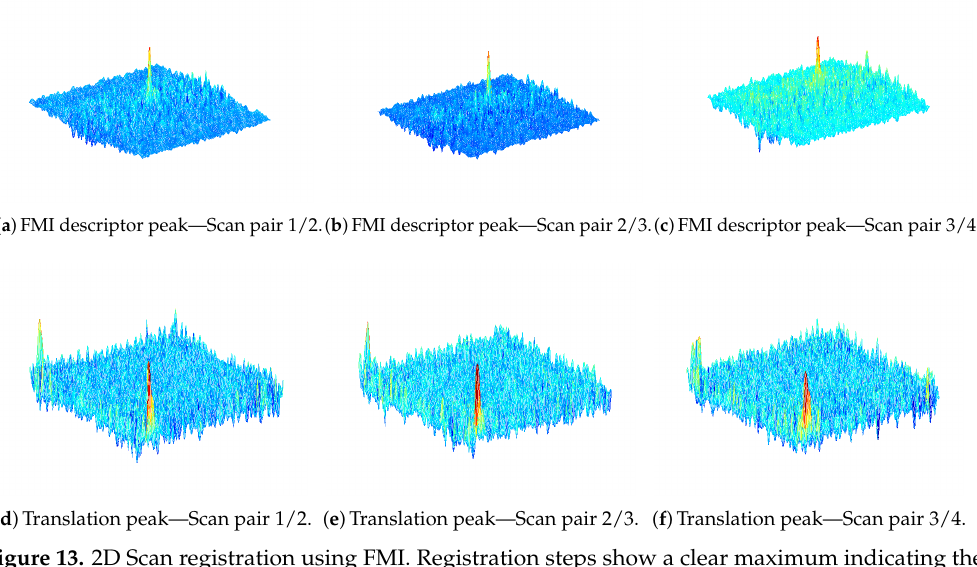
Figure 13. 2D Scan registration using FMI. Registration steps show a clear maximum indicating the correct transformation